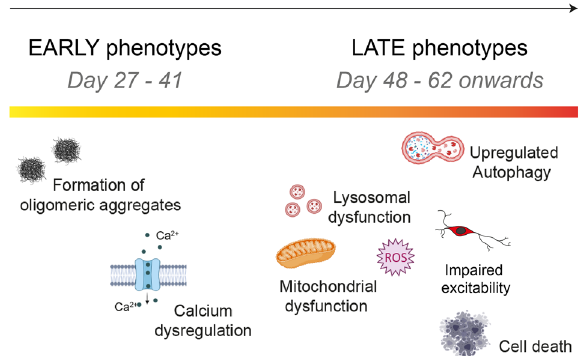
Fig. 8 Cellular phenotypes sequentially appear in mDA neurons. A schematic illustration showing temporal sequence of cellular phenotypes in the human PD model. The earliest abnormality is the accumulation of small aggregates with a speci fi c beta-sheet conformation (at day 27 of differentiation). This is followed by another early phenotype which is impaired calcium signalling by day 34 of differentiation. When mDA neurons spend longer in culture, only after day 48, mitochondrial dysfunction, oxidative stress, and lysosomal dysfunction appear as late phenotypes, as well as, upregulated autophagy, impaired excitability and cell